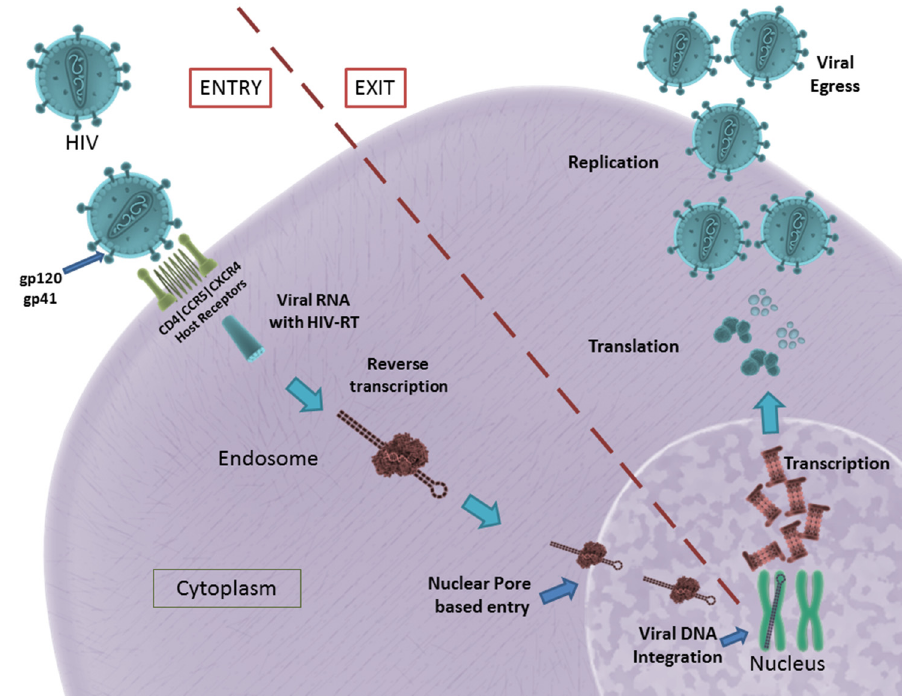
Figure 1. HIV entry and egress, as illustrated: Pictured are the important host receptors CD4, CCR5 and CXCR5. The viral glycoproteins gp120 and gp41 play an important role in attachment and entry; viral RNA is made and integrated into the host genome. After replication is facilitated, viral particles egress from the host cell. CC BY 4.0 license